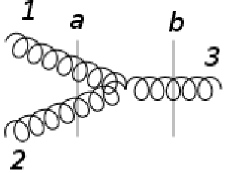
Figure 2. Diagrammatic representation of Y 21 t . Letters denote configurations of particles before and after the interaction, a refers to particles 1 and 2 and b to particle 3. For more details about notation see Ref.